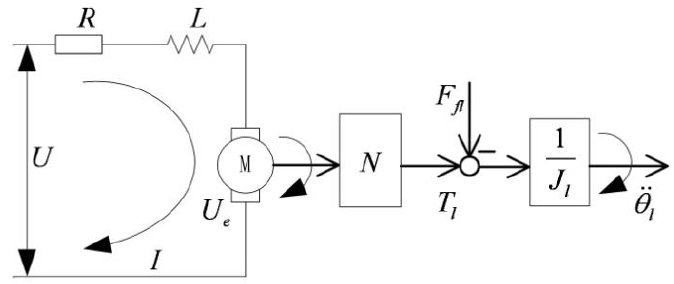
Figure 7. Block diagram for a simplified gear drive system with fixed transmission